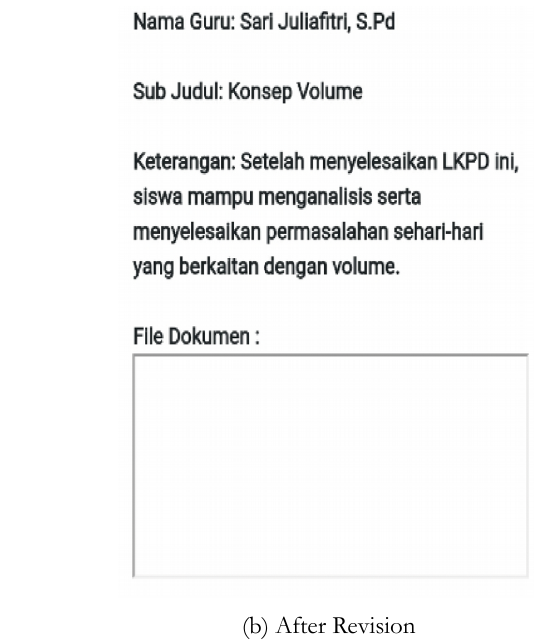
Figure 7. Layout Before & After Revision